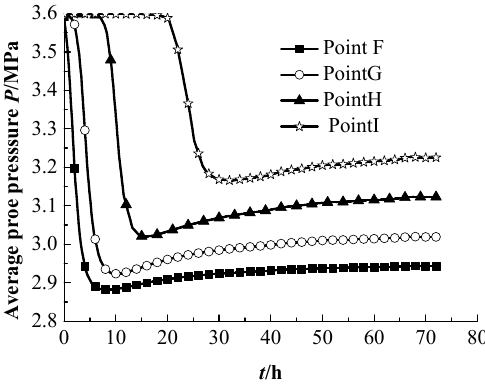
Figure 11. Curves of average pore pressure with time at different positions.